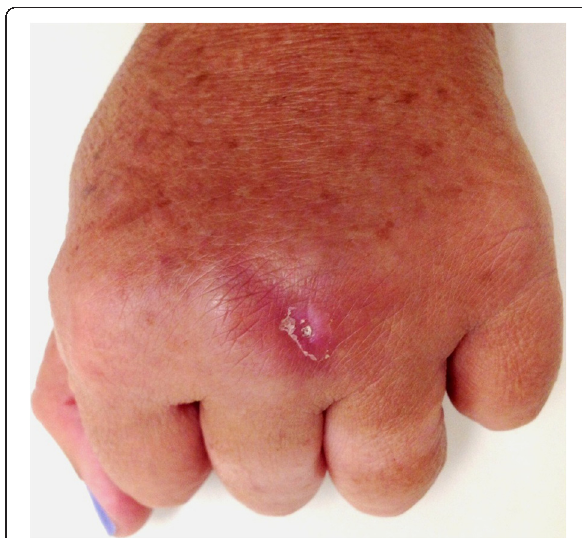
Figure 2 Chronic infiltrated plaque on the dorsum of the left hand of the patient. The image shows the central ulceration caused by the beak of the